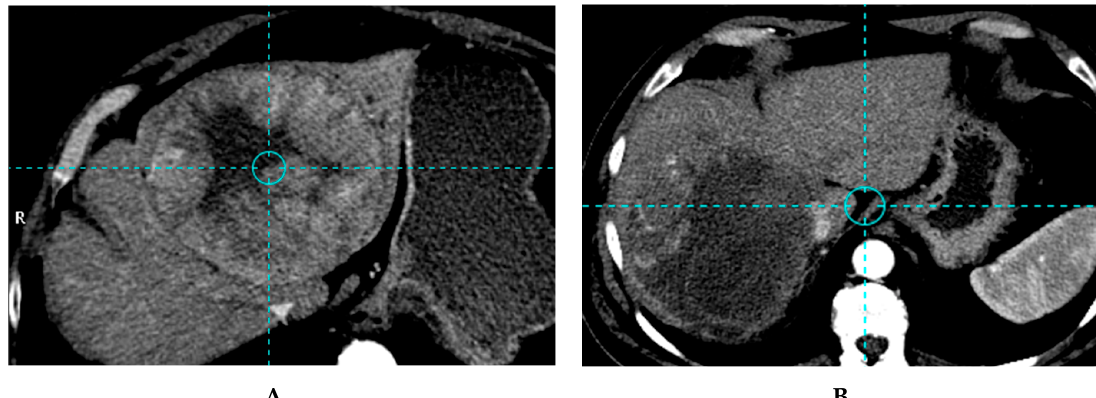
A B Figure 3. Example of a patient treated with a personalised dosimetry approach, with a lesion accurately treated (tumor dose higher than the 205 Gy threshold). ( A ) Based CT image of 15 cm unifocal right HCC with the invasion of the veina cava in a 64-year-old patient with good performance status (ECOG 0) and liver functions (Child Pugh A5). The patient received a treatment of the right lobe with 7.06 GBq of 90 Y glass microspheres using the personalized dosimetry approach delivering 294 Gy to the large lesion and 173 Gy to the right lobe. CT image, 3 months after SIRT, partial response of the huge lesion was obtained using EASL criteria, as no recurrence on the left lobe and no extra hepatic spread ( B ). The patient was still in good performance status (ECOG 0) and liver functions (Child Pugh A5) and a right hepatectomy was performed with veina cave reconstruction. At last follow-up evaluation, 22 months after SIRT, the patient was still in complete response.